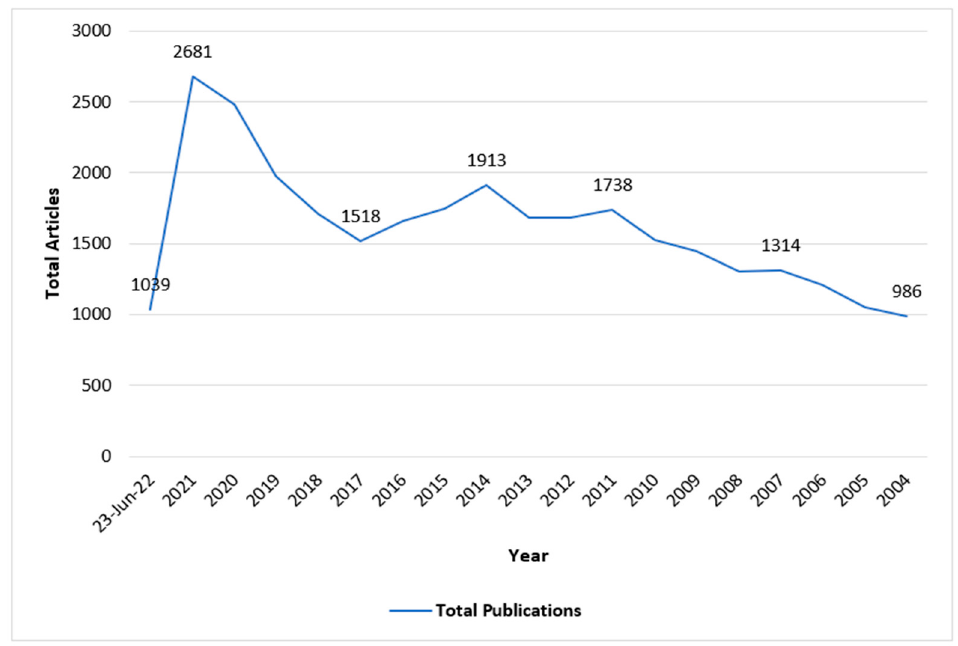
Figure 4. Trend analysis of journal articles on dentists by year.